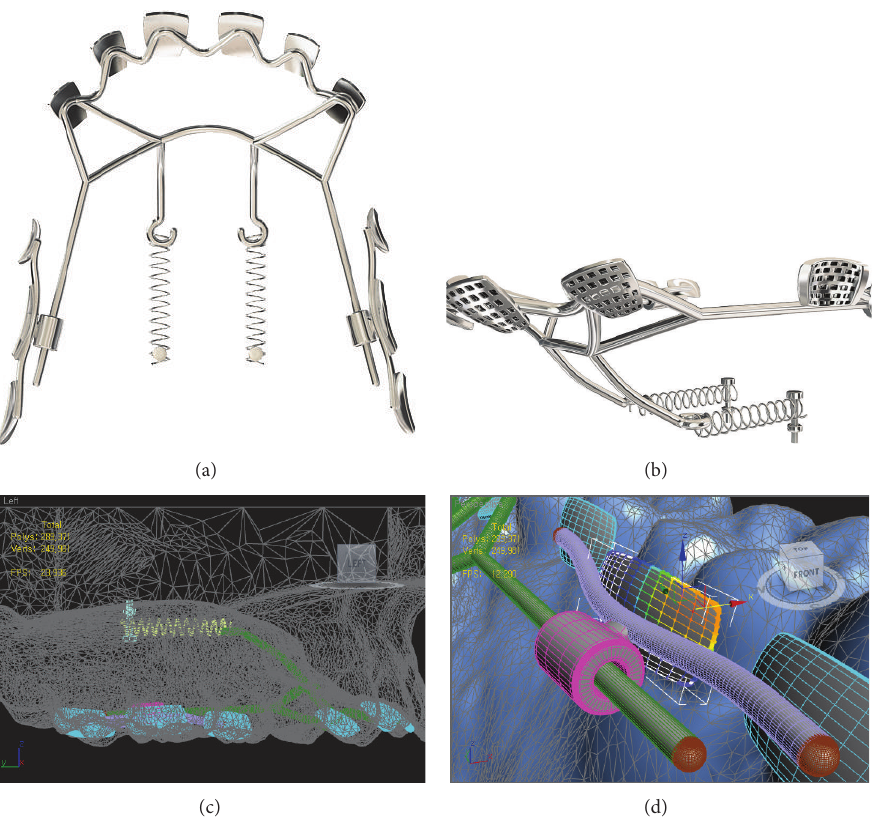
Figure 4: Final design of the appliance in the 3D CAD software. (a) Occlusal view. (b) Retention feature was provided on the lingual pad base. ((c) and (d)) Lingual arch wire was connected to the anterior lingual